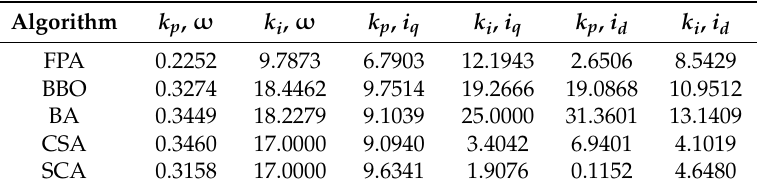
Table 3. Optimal gains for PI controllers.